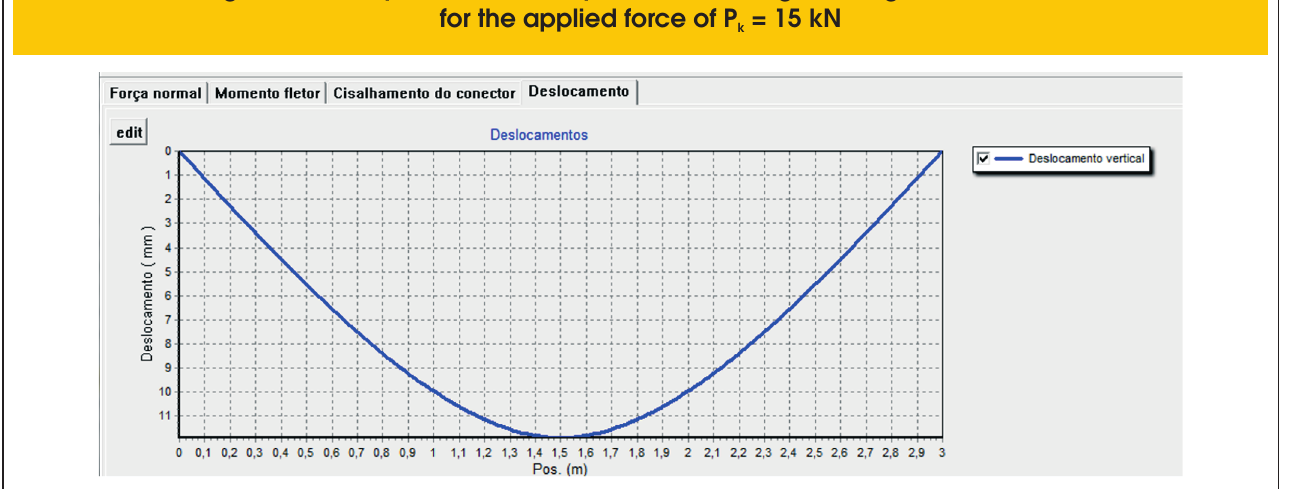
Figure 11 – Graph of vertical displacement along the length of the beam for the applied force of P = 15 kN k